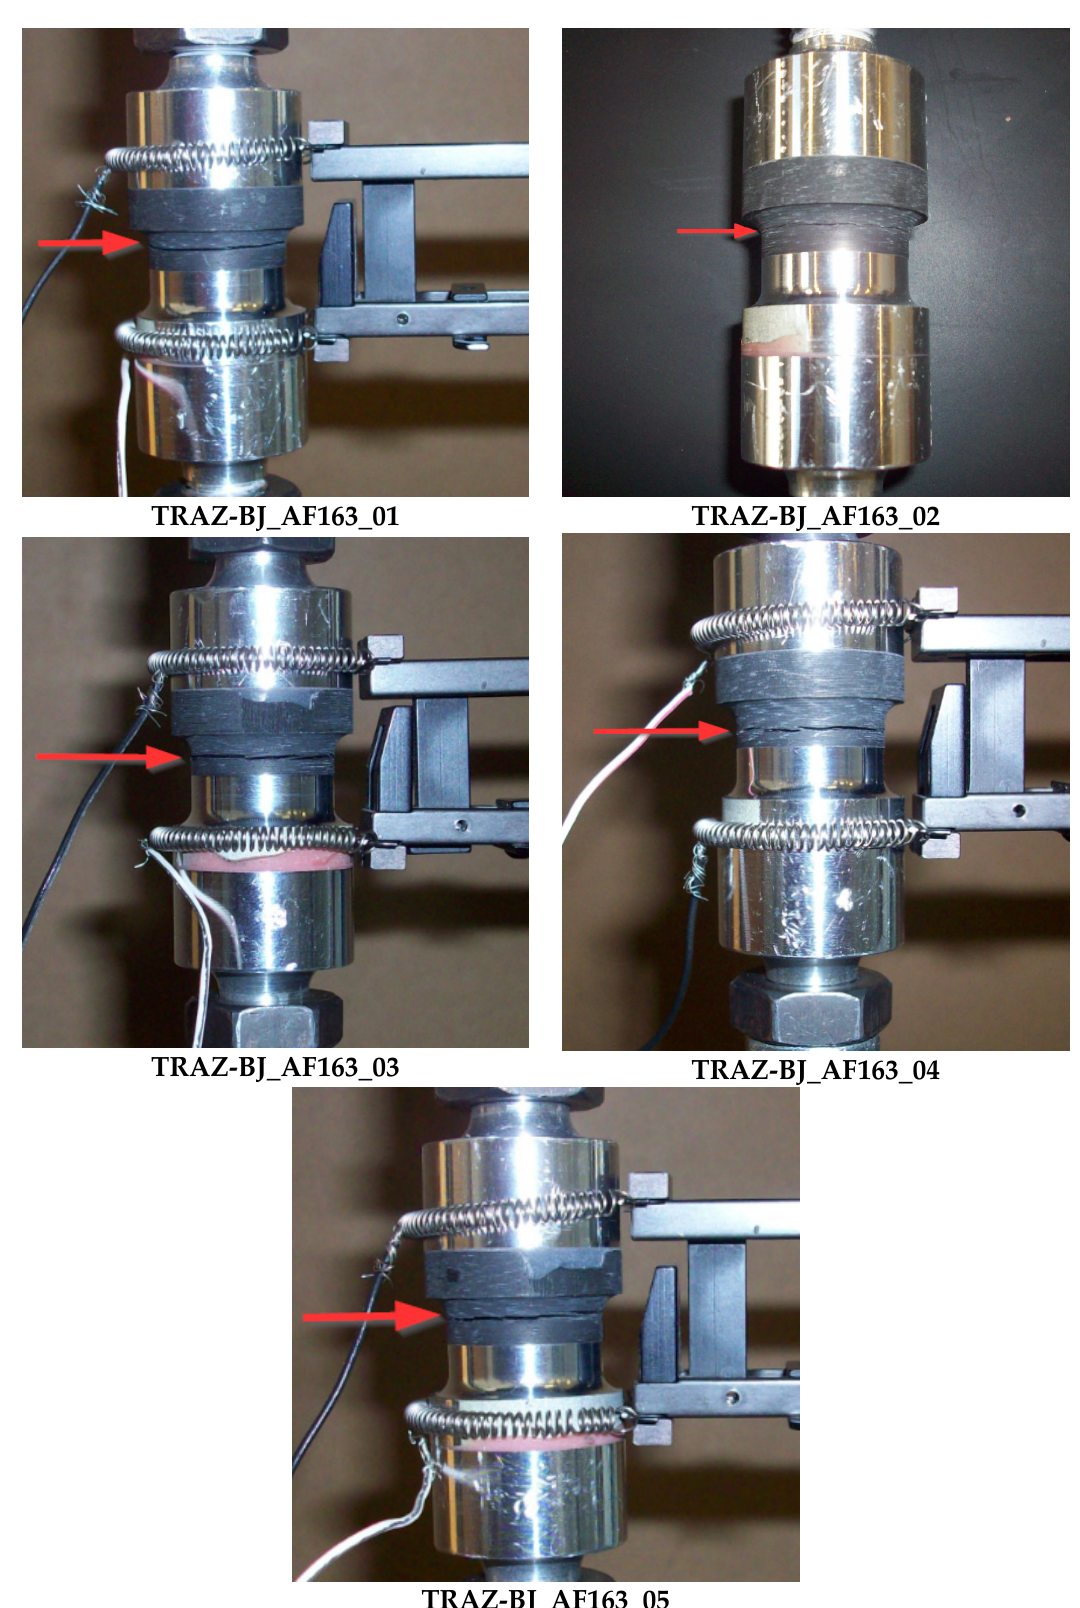
Figure 11. Highlight of failure location in TRAZ-BJ_AF163 tests. The red arrow points out the failure section.